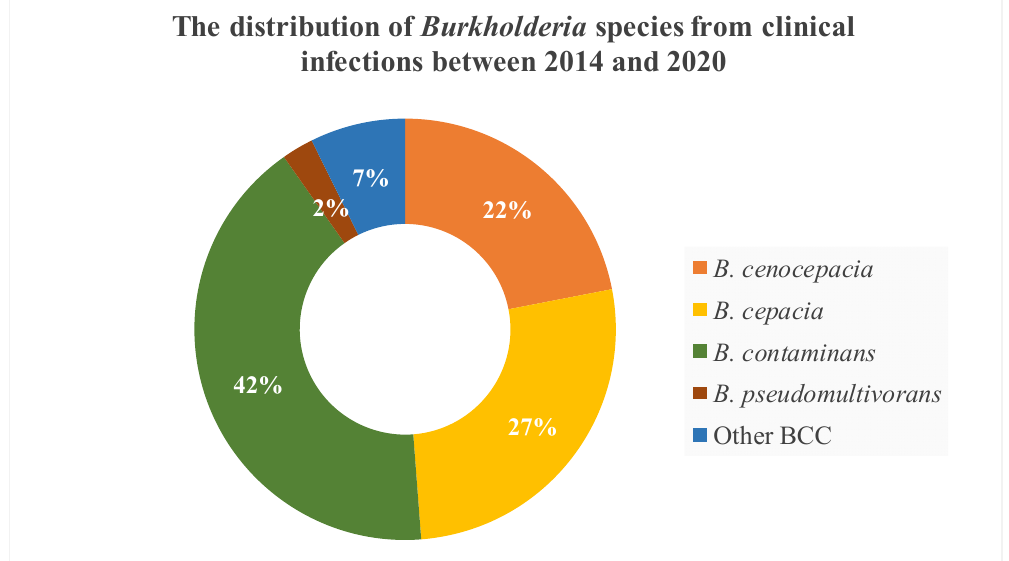
Figure 1. The species distribution of Burkholderia cepacia complex (BCC) from different clinical infections between 2014 and 2020.